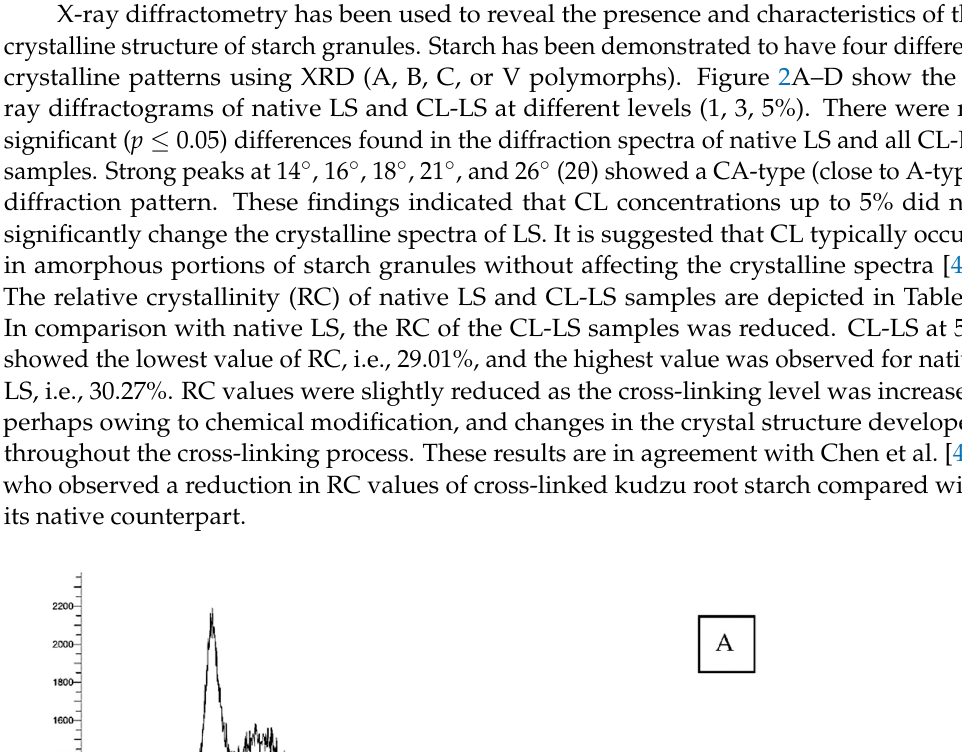
Figure 1. Effect of storage duration on the transmittance (%) of native and cross ‐ linked (CL) lotus seed starch.